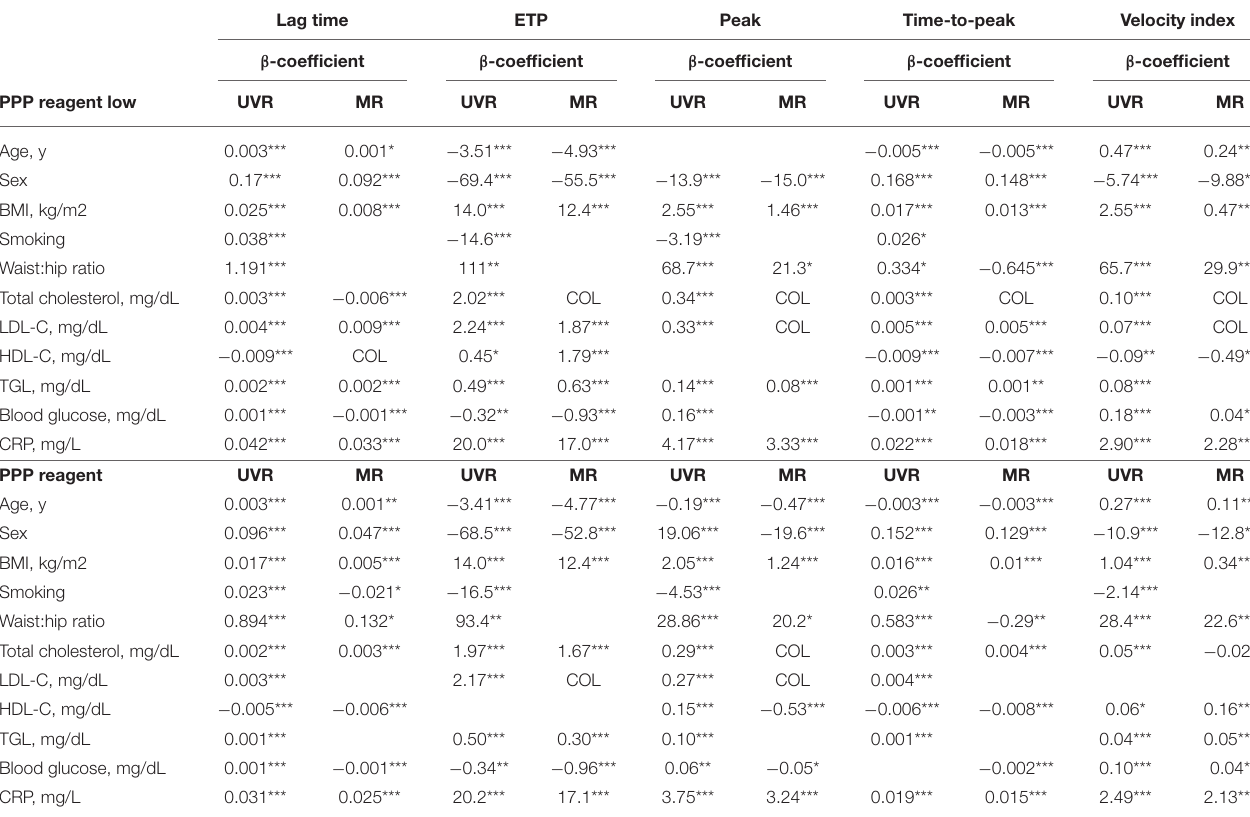
TABLE 4 | Determinants for TG parameters in linear regression analysis. Lag time ETP Peak Time-to-peak Velocity index β -coefficient β -coefficient β -coefficient β -coefficient β -coefficient